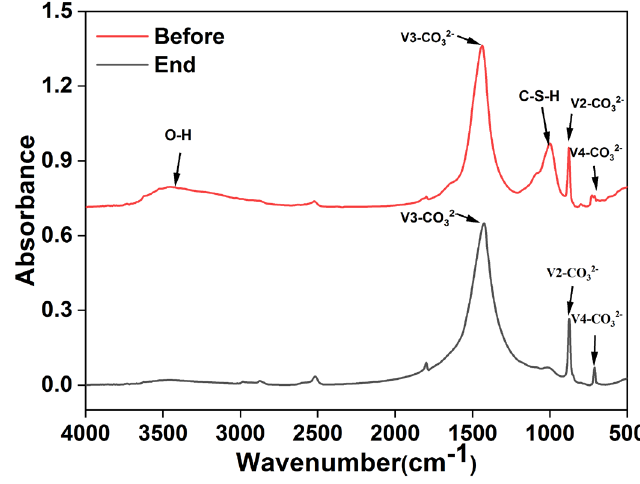
Figure 6. FT − IR pattern of RMPC before and after reaction.